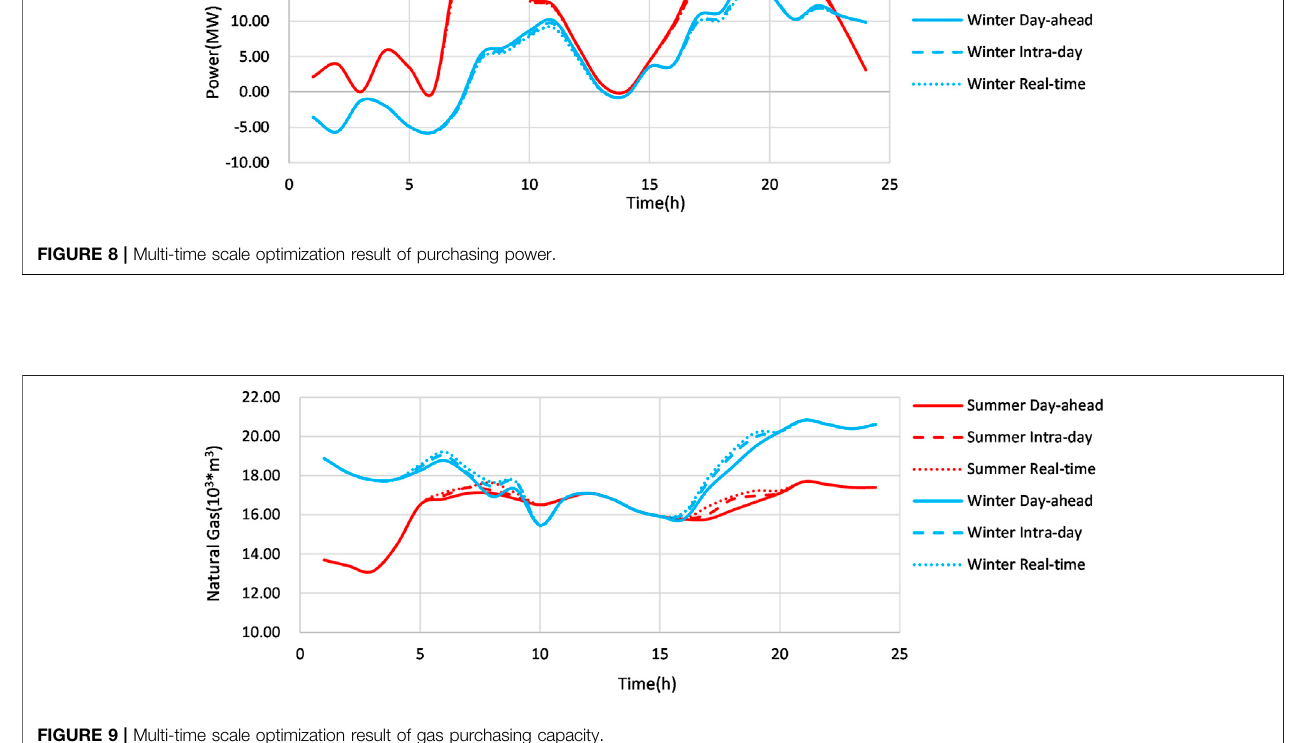
FIGURE 9 | Multi-time scale optimization result of gas purchasing capacity.